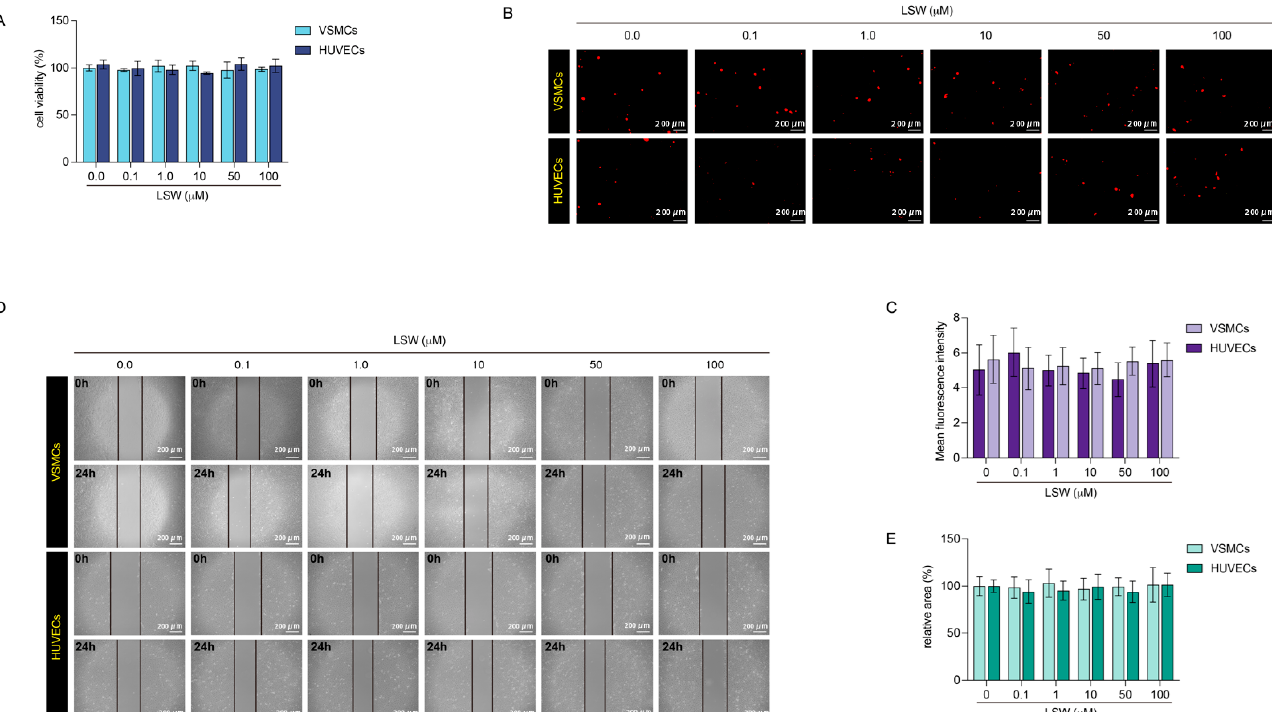
Figure 1. The effects of tripeptide LSW on proliferation and oxidative stress of VSMCs and HVUECs. The VSMCs and HUVECs were treated with LSW. ( A ) The CCK-8 assay was used to test the proliferation VSMCs and HUVECs with or without LSW incubation. ( B ) Images of dihydroethidium staining in the VSMCs and HUVECs with or without LSW incubation in different concentrations (100 × magnification, scale bar: 200 µ m). ( C ) The mean fluorescence intensity of the DHE-staining images was analyzed by Image J software. ( D ) The migration of VSMCs and HUVECs was evaluated by a wound-healing assay. The scratch of the wound healing was recorded at 0 and 24 h (100 × magnification, scale bar: 200 µ m). ( E ) The relative area of the wound healing scratch at 24 h was measured by ImageJ software (version 2.1.0) and the results of each treatment group were shown to the corresponding control (without LSW treatment). Data represent the mean ± SD of three independent